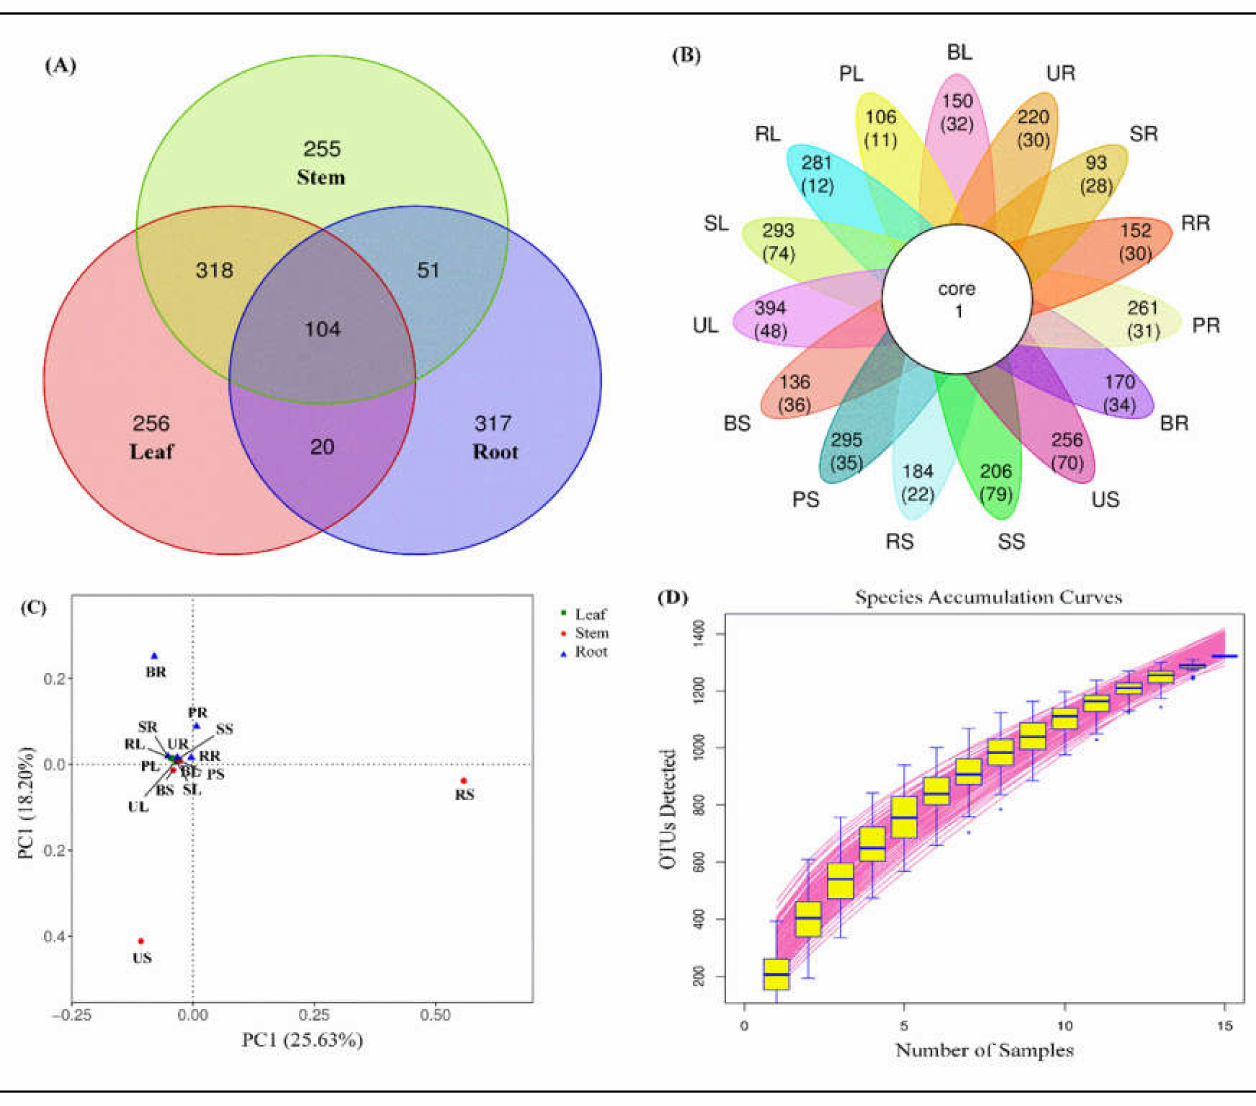
Figure 2. Operational taxonomic unit (OTU) clustering among five sugarcane species. ( A ) Venn diagram showing several unique and shared OTUs in combined plant samples. ( B ) Petal map displaying the number of unique and shared OTUs, the outermost circle represents the sample name; the petals include two rows of numbers, with the number of all OTUs contained in each sample and the number of OTUs unique to each sample in the following brackets; the white circle in the center represents the core OTU quantity. ( C ) Principal component analysis (PCA) showing the percentage of each OTU in each sample, and ( D ) species accumulation curve describing the increase in species as the sampling amount increases and an effective tool for understanding the species composition of surveyed plots and predicting species